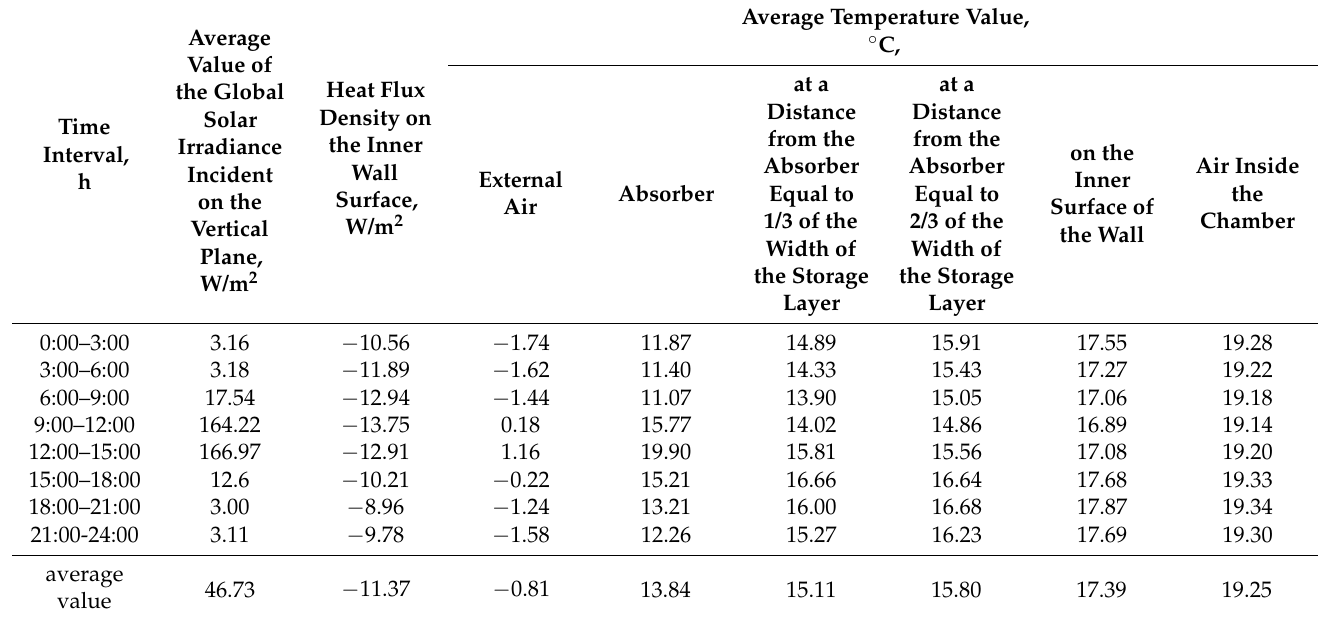
Table 6. Summary of the results of the tests carried out in January—the middle sector of the wall.